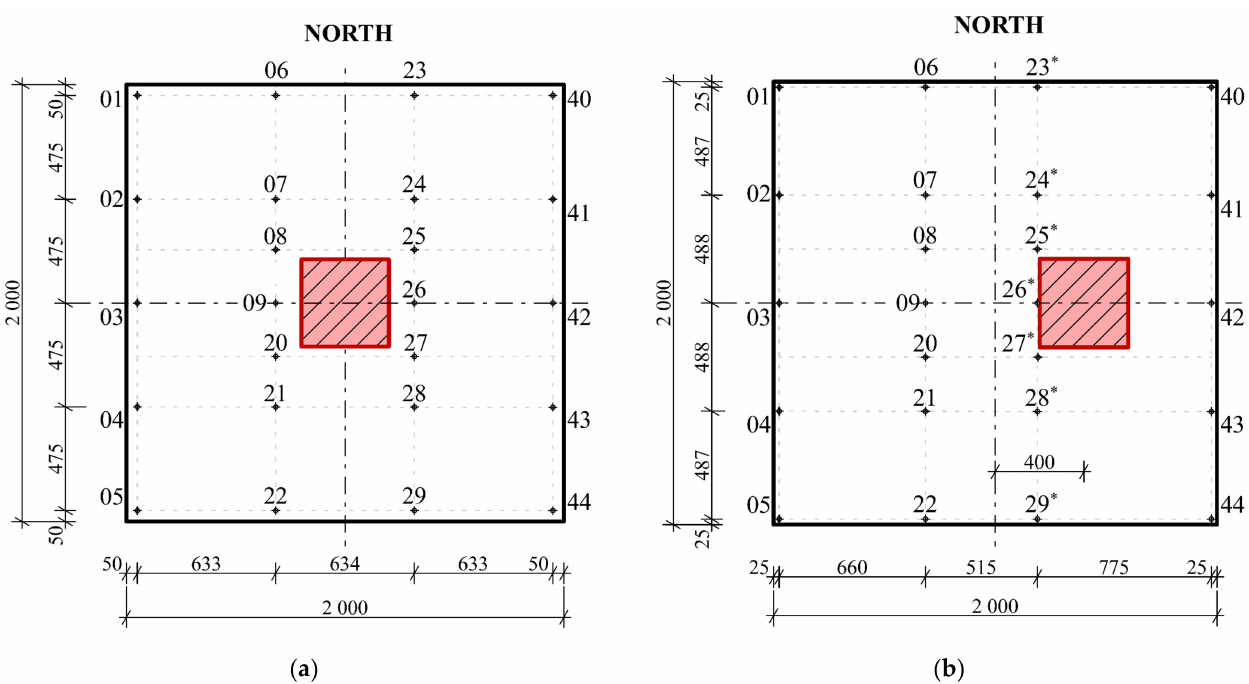
Figure 10. Slab: ( a ) centrically loaded slab G10; ( b ) eccentrically loaded slab G11.